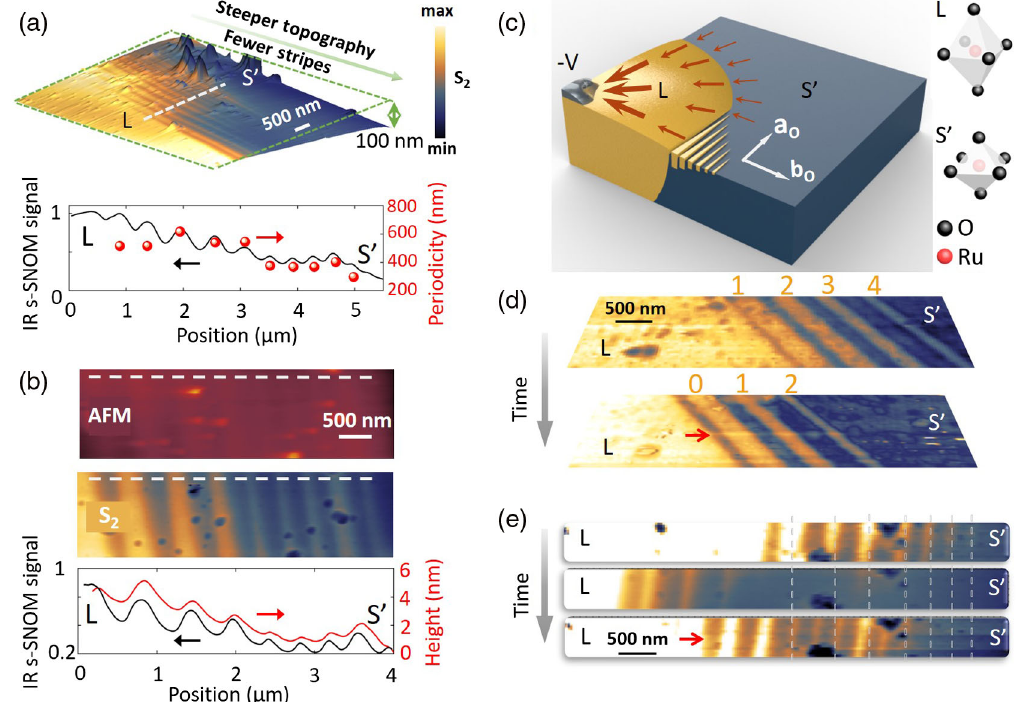
FIG. 4. Topography and progression or regression of the PB. (a) Top: The sample topography overlaid with the s-SNOM image in Fig. 2. For a larger height change from the L to S 0 state, fewer stripes are observed. (b) AFM topography (top) and IR s-SNOM signal S2 imaging (middle) of eight stripes across the PB. The bottom figure shows that the variation in topography (red curve) has a one-to-one correspondence to the IR signal (black curve). (c) Schematic of a striped surface metallic layer at the PB, L phase bulges due to a larger out-of-plane lattice constant; red arrows represent the magnitude and direction of the current density. (d),(e) Progression or regression of the PB taken with repeated IR s-SNOM imaging on three different samples under a current fluctuation around 12 mA. (d) The occurrence of new metallic and insulating stripes with a width on the order of approximately 100 – 200 nm during the retraction of the phase front. (e) The fluctuation of the phase front. The current fluctuation and the time elapsed between the consecutive images taken in all the subfigures are less than 0.1 mA and 20 min,